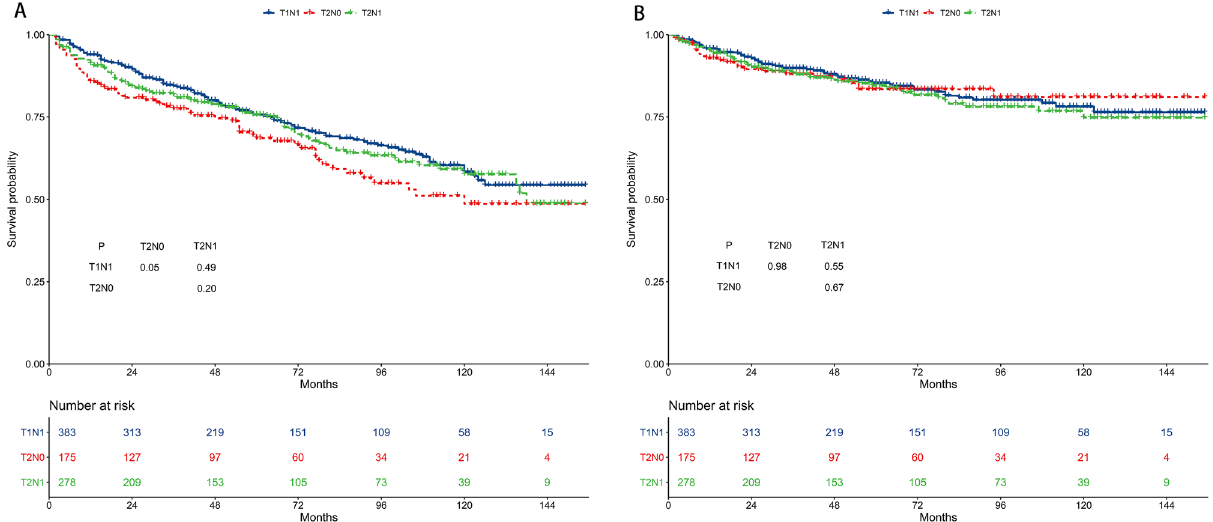
Figure 2. Survival outcomes of the T1N1, T2N0, and T2N1 subgroups. ( A ) Overall survival. ( B ) Cancer- specific